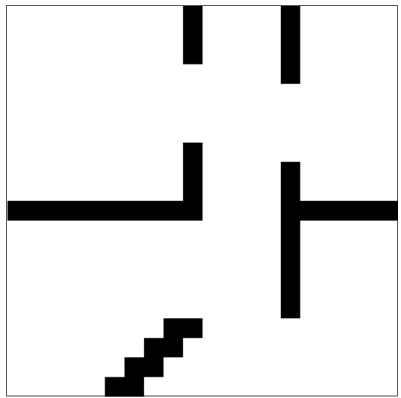
Figure 5. Training environment. Black areas are occupied by obstacles, and white areas are traversable for